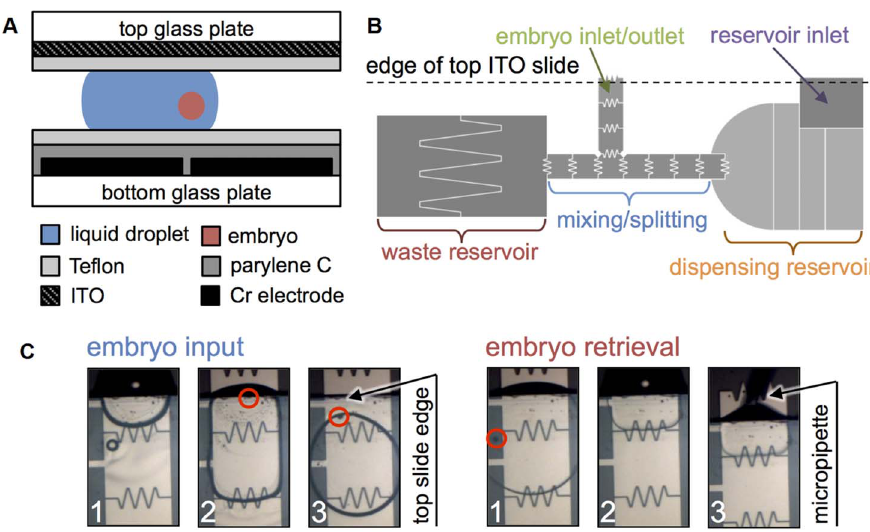
Figure 2. Key device design elements and fabrication layers. (A) Device structure and fabrication. Electrodes (1 mm 6 1 mm) were separated by a 20 m m gap. (B) Regions for vitrification medium dispensing and for embryo loading/extraction. The top ITO slide is placed on the device in a manner that exposes portions of the top electrodes in the dispensing reservoir and exposes portions of the leg of the T-shaped electrodes, for medium and embryo loading, respectively. (C) Embryo is input and extracted by actuating electrodes at edge of top glass slide.